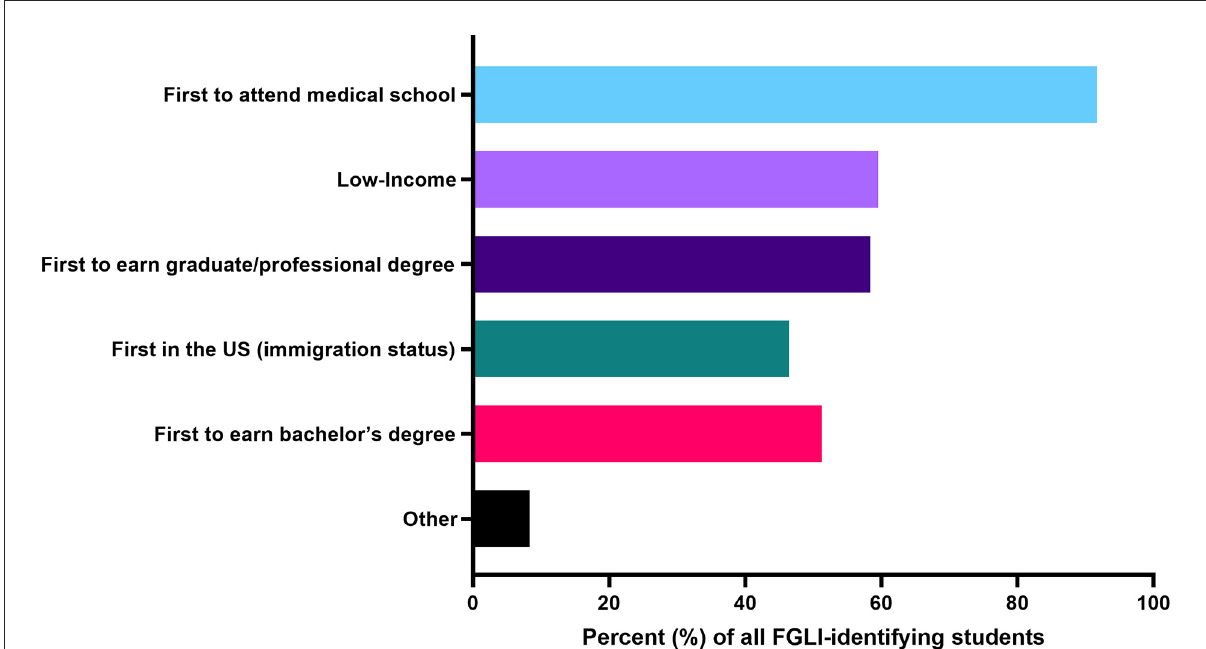
FIGURE1 In a survey of all medical at Harvard Medical School in 2020, 84 students identified as first-generation/low-income, with 46.4% of those identifying as being the first generation in their family to be in the US (immigration status), 91.7% identifying as the first in their family to attend medical school, 51.1% identifying as the first in their family to earn a bachelor’s degree, 58.3% identifying as the first in their family to earn a graduate/professional degree, and 59.5% identifying as